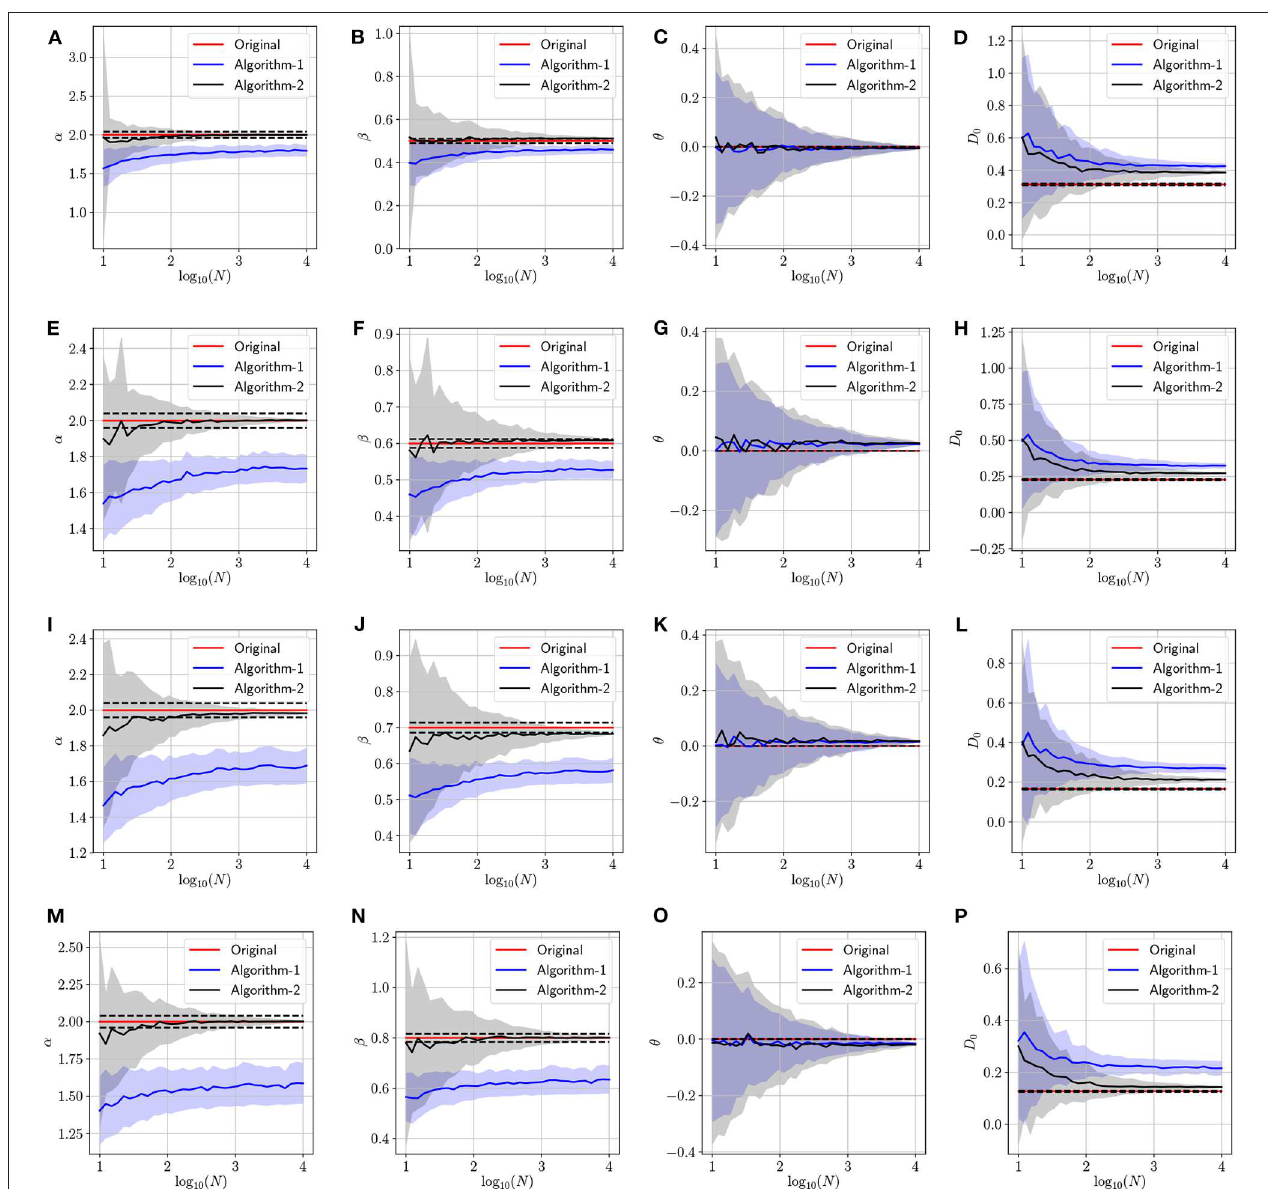
FIGURE 6 | Determining the parameters of the fractional Brownian motion via the two proposed algorithms while varying the number of trajectories. The dotted line indicate 2 % error tube around the original parameter value in the red: (A–D) with H ( α 2, β 2 H , θ 0, D 0 0.22), (I–L) with H = = = =